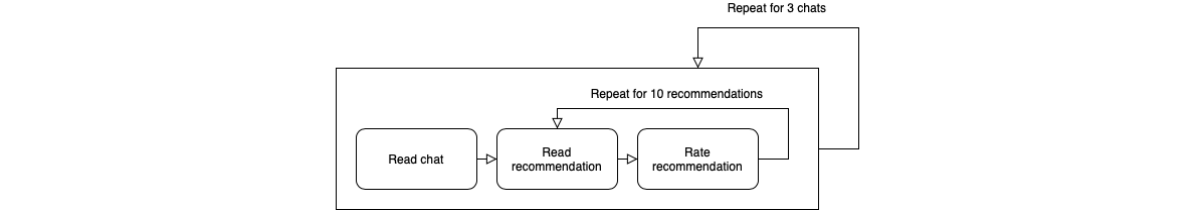
Figure 4. Procedure diagram of the second part of the experiment.